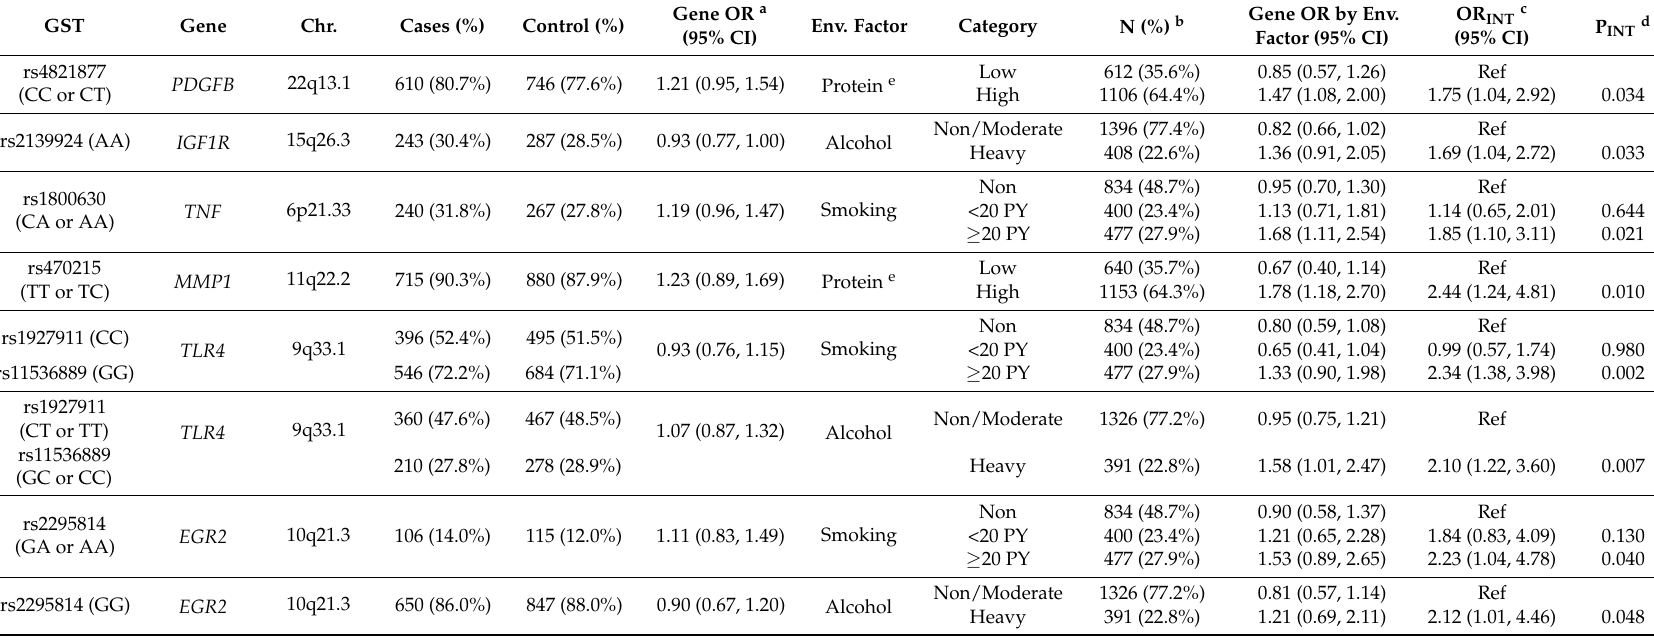
Table 3. Effects of gene-environment interactions significant at 5% level between gene-specific trees and environmental factors on rectal cancer